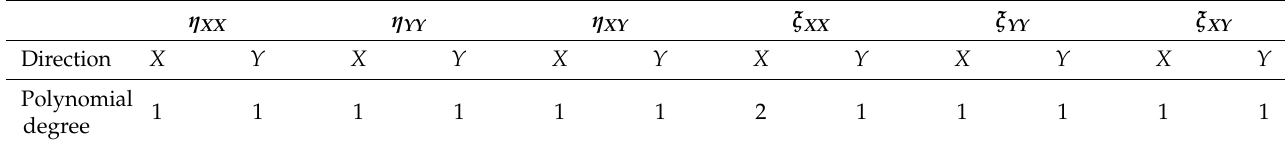
Figure 13. Uniform pressure: loading and boundary conditions. Table 4. Uniform pressure: selected polynomial pre-extrapolation orders.